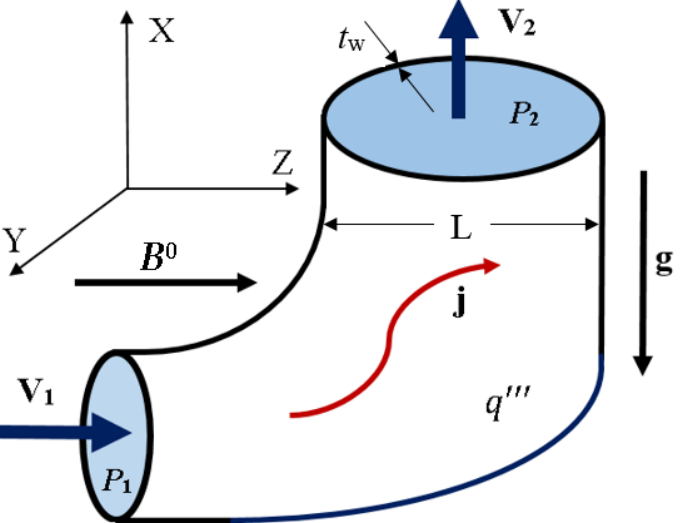
Figure 6. Sketch of a pressure driven LM flow in a complex geometry thin-walled duct with applied magnetic field and volumetric heating in the presence of gravity forces.